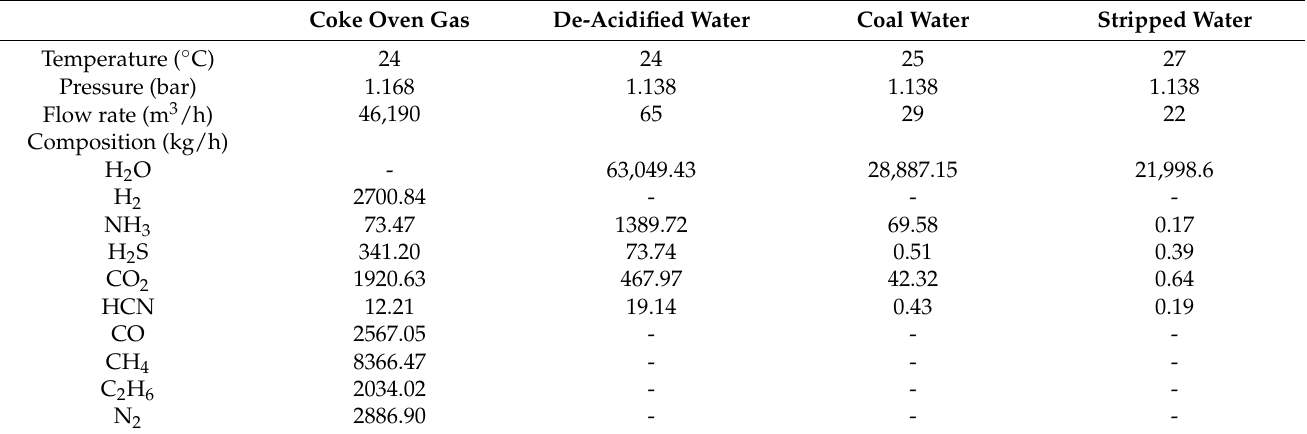
Table 2. Input parameters.